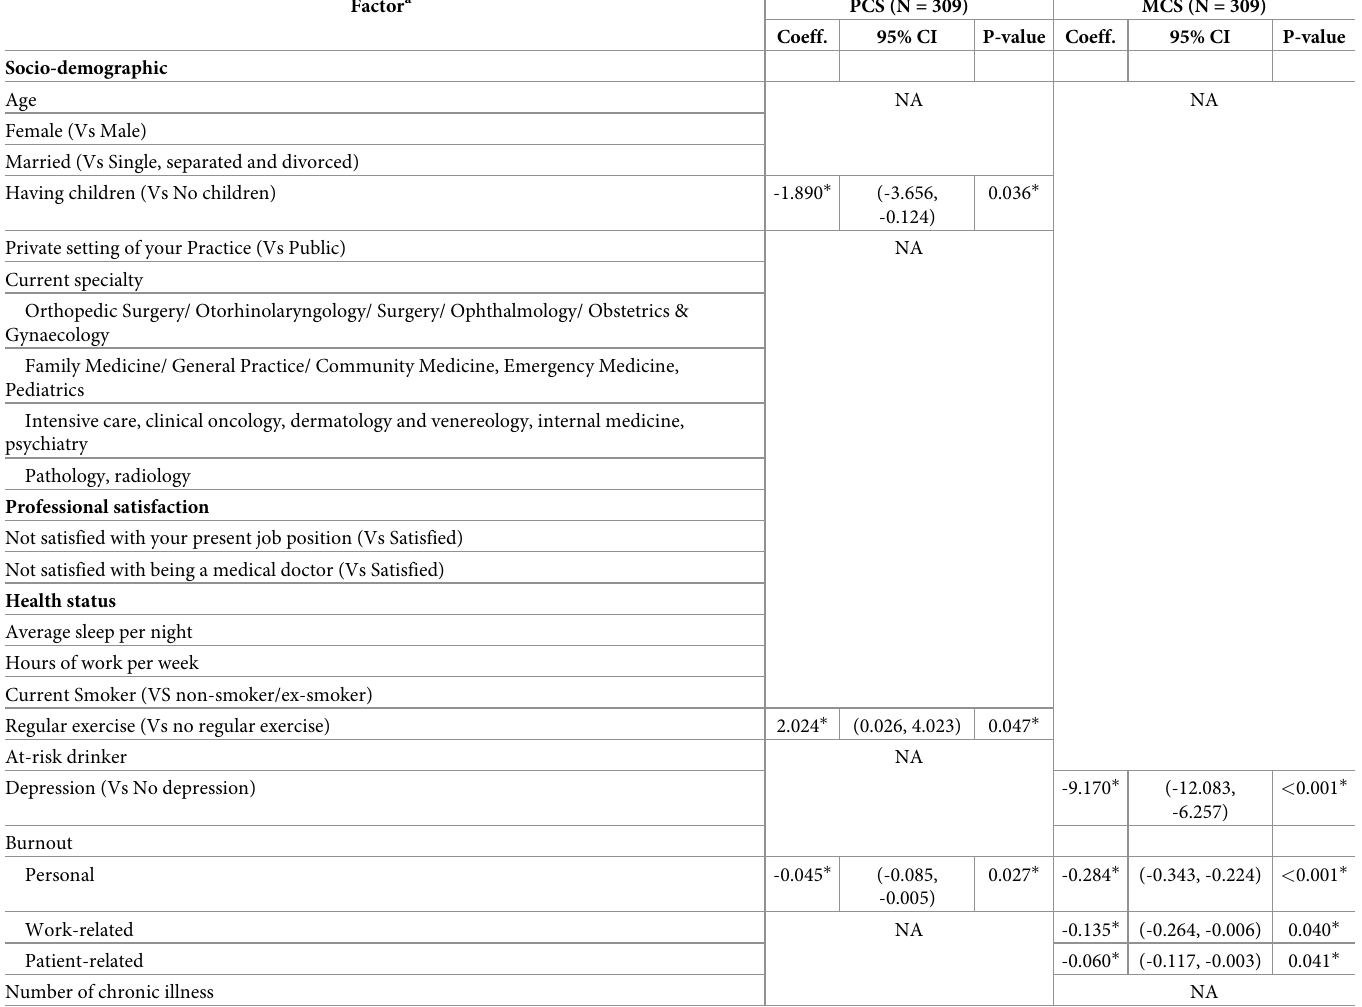
Table 3. Sociodemographic, professional satisfaction and health status associated with MCS and PCS by regression